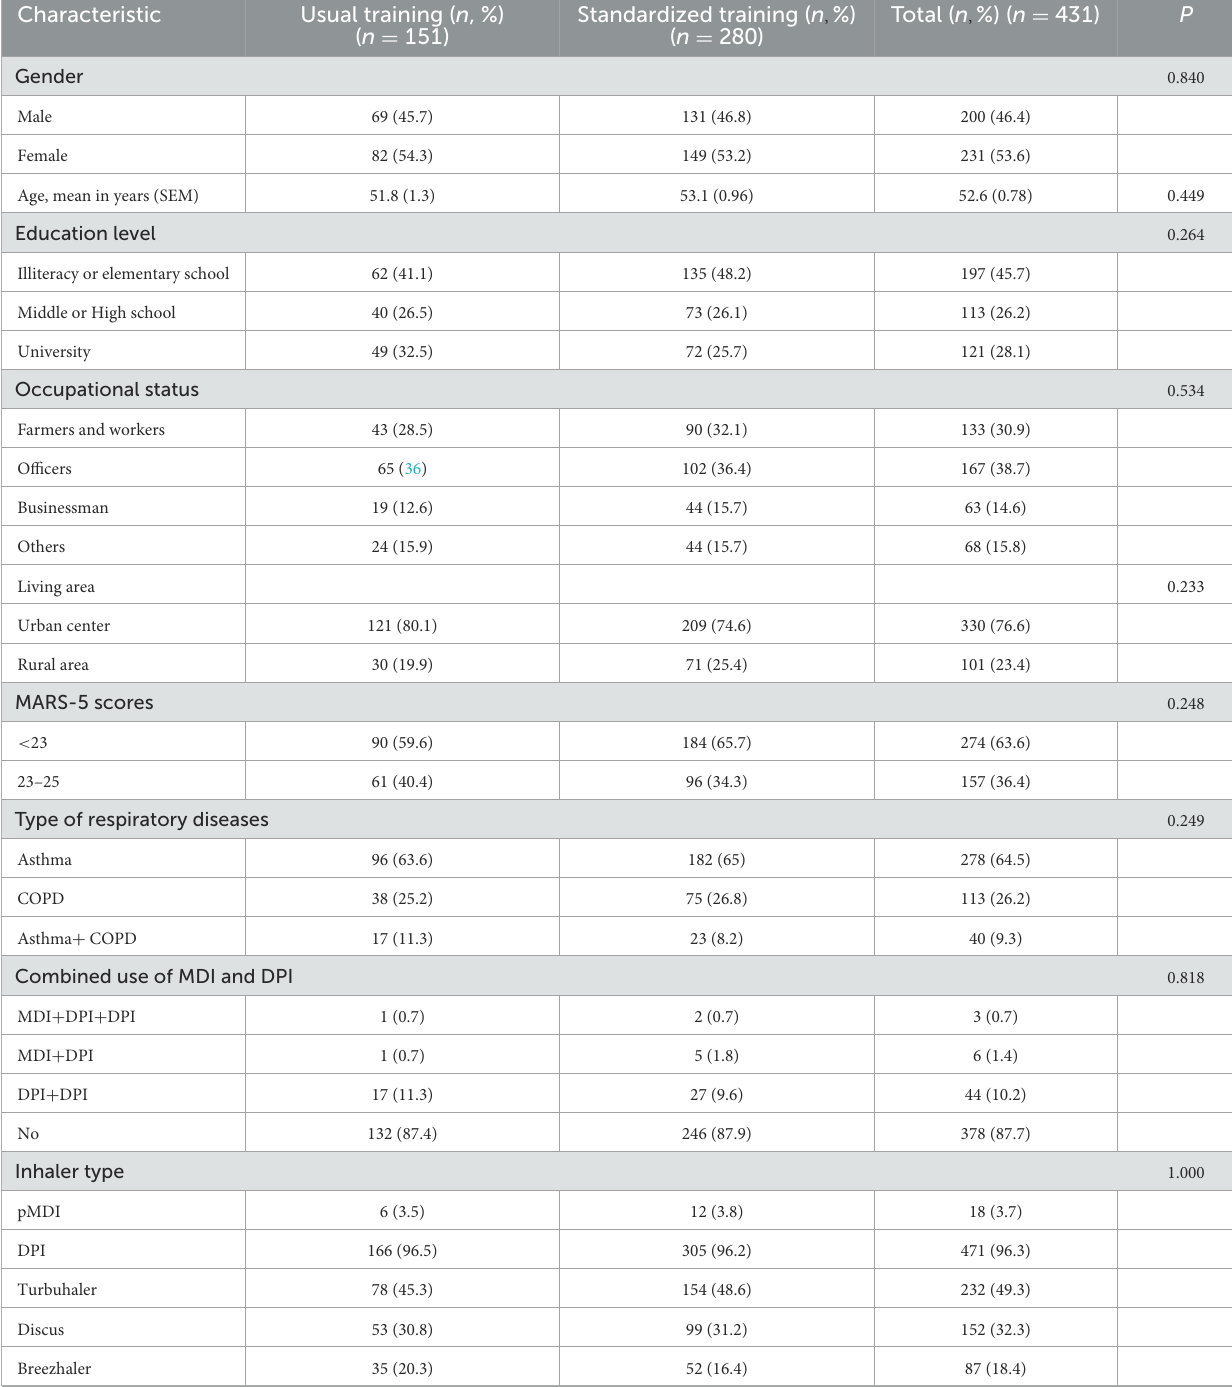
TABLE 3 General information of subjects and the inhaler device used in the two groups.